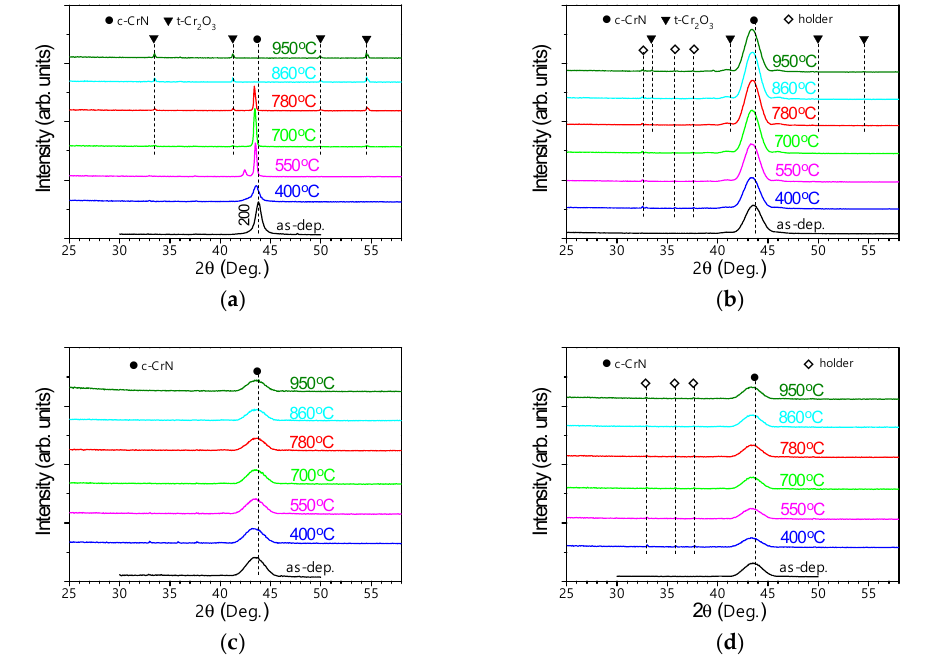
Figure 5. Evolution of XRD patterns under air annealing for CrN reference film ( a ); and CrN/SiN x multilayered films with different thickness of CrN and SiN x elementary layers: ( b ) 5 nm/2 nm; ( c ) 5 nm/5 nm; and ( d ) 5 nm/10 nm.